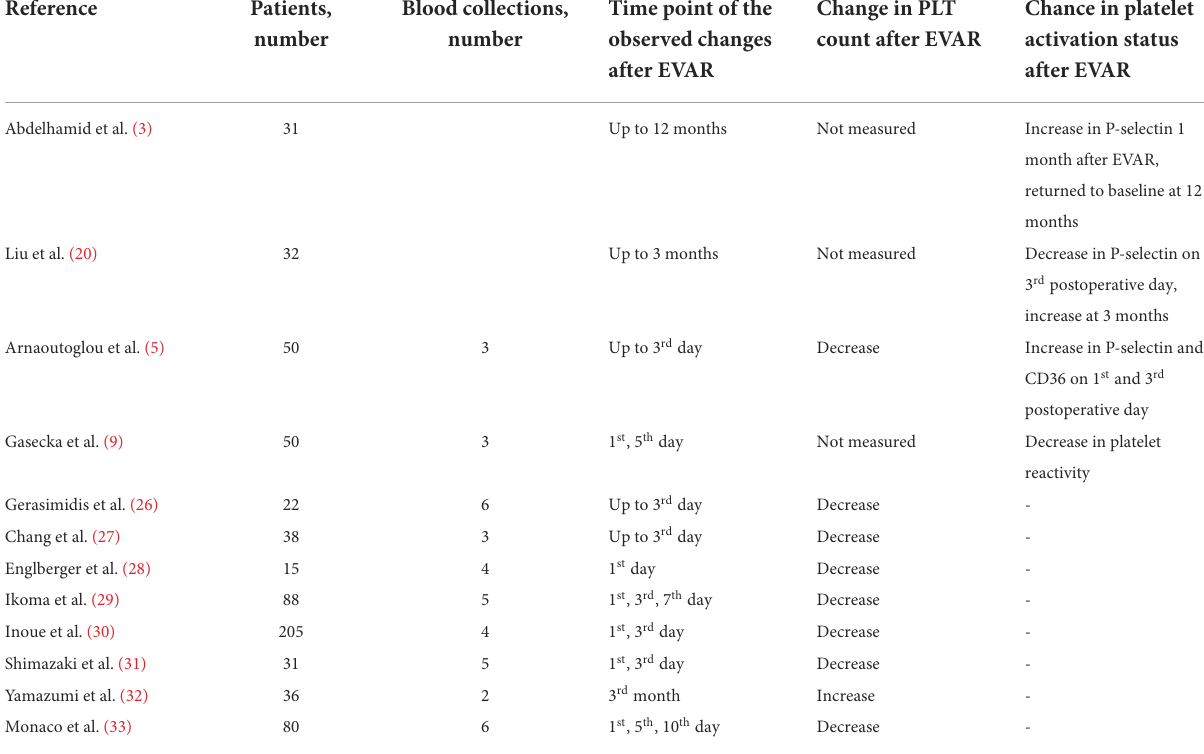
TABLE 1 Summary of change of platelet indices after endovascular aortic aneurysm repair